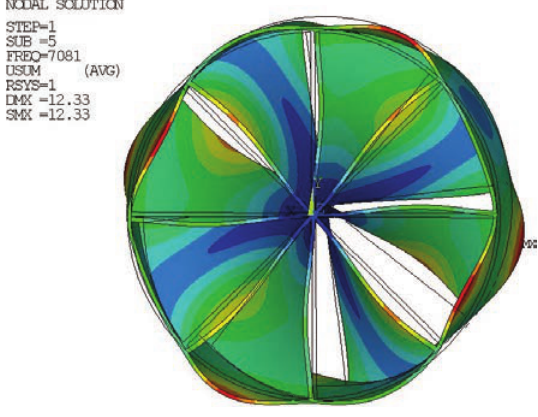
Fig.11.Fifth natural frequency and modal shape of 8A impeller Figure 11. Fifth natural frequency and modal shape of 8A